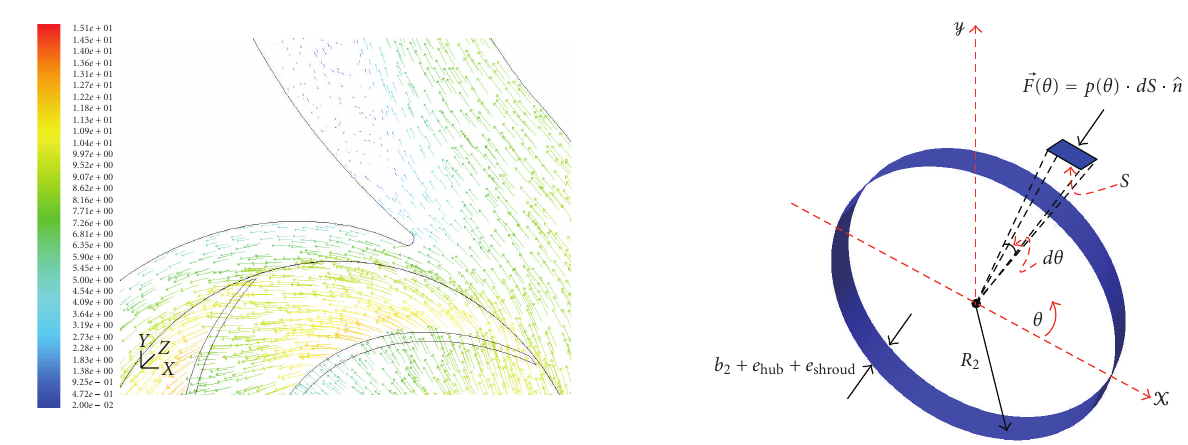
Figure 11: Zoom on the volute tongue zone at q v = q bep for the original pump—numerical velocity field prediction.